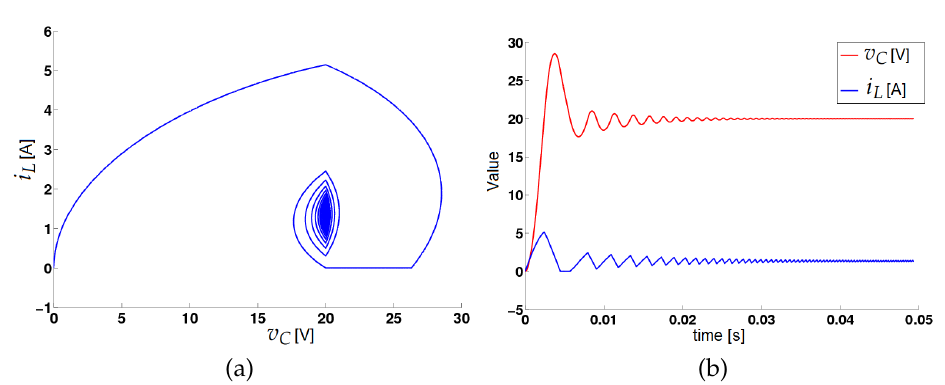
Figure 8. Dynamic behavior in steady- and transient-state operations: ( a ) phase diagram and ( b ) temporal evolution.